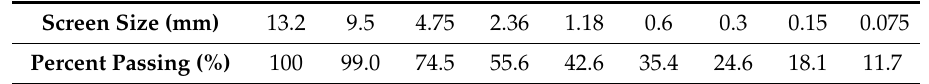
Table 7. Gradation of the epoxy asphalt concrete (EAC) mixture (percentage by weight passing